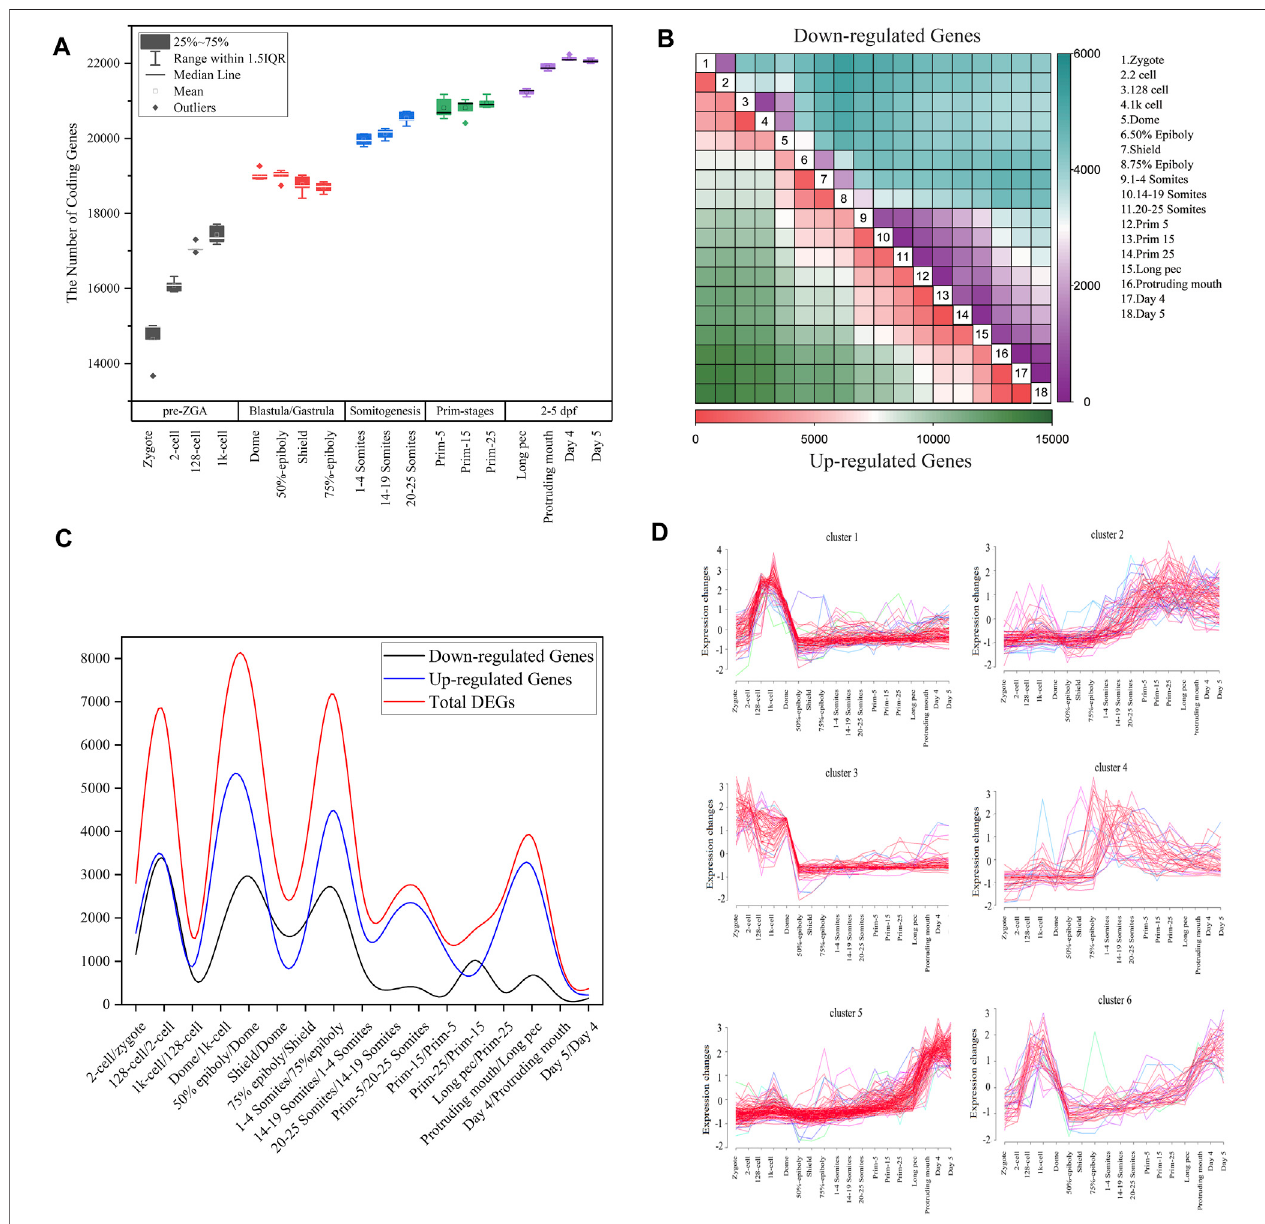
FIGURE1 | Gene expression dynamics during zebra fi sh development. (A) The boxplot of detected coding genesat 18developmental stages. (B) The heatmap of DEGs between any two stages during embryogenesis. In all contract groups of DEGs, the late developmental stage is numerator, and the early developmental stage is denominator.Thenumberofupregulatedanddownregulatedgenesarerepresentedbythecolorsinthebottomanduppertriangular,respectively. (C) Thedistributionof the number of differentially expressed genes for all consecutive stages of embryo development. The upregulated or downregulated gene refer to a gene that is upregulated or downregulated between two consecutive time points (D) Cluster analysis of downregulated genes between dome and 1k-cell stages based on Mufzz.